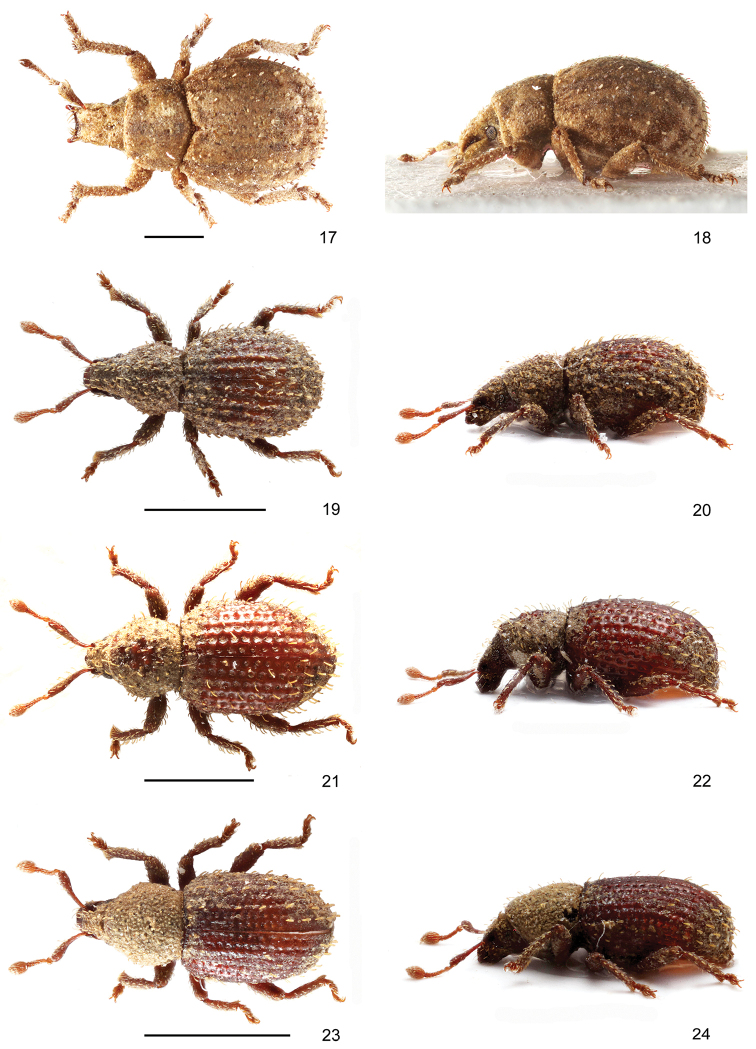
Habitus of species of Rhinodontus and Trachyphloeosoma: 17, 18Rhinodontus
sawadai, female, dorsal and lateral view 19, 20Trachyphloeosoma
honza sp. nov., paratype, female, dorsal and lateral view 21, 22T.
jirka sp. nov., paratype, female, dorsal and lateral view 23, 24T.
martin sp. nov., paratype, female, dorsal and lateral view. Scale bars: 1 mm.